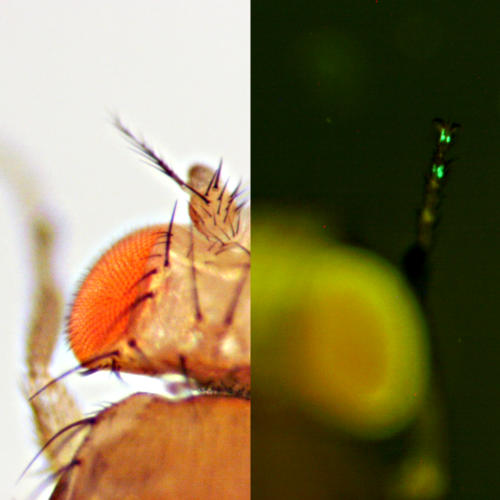
Genes expressed at the tip of fruit flies' legs determine which host plant they choose as their breeding grounds. (Image: T. Matsuo and J. Yasukawa)